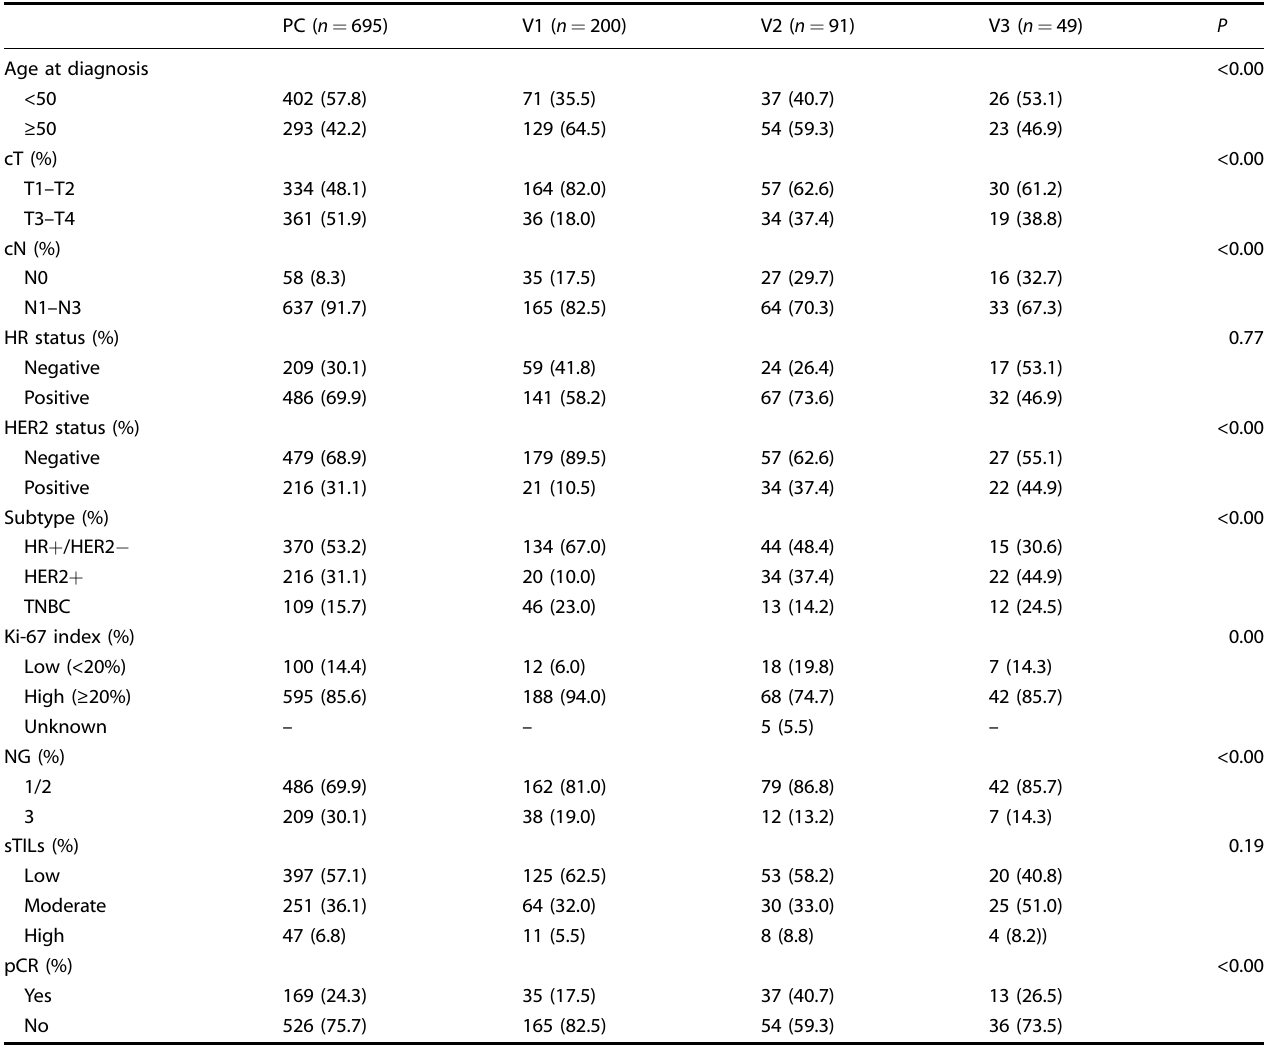
Table 1. Demographic and clinic-pathological